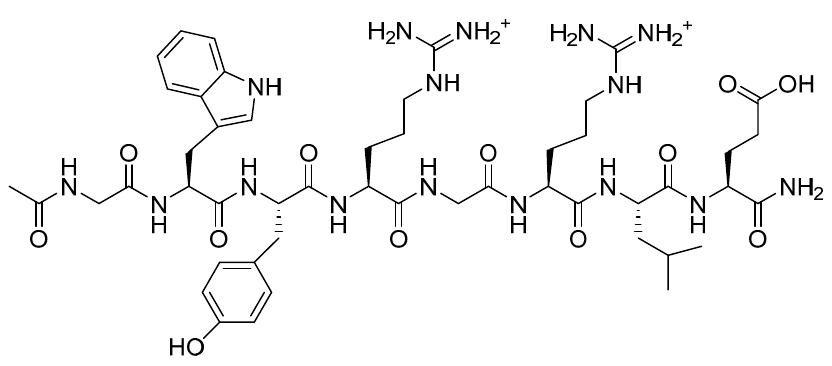
Figure 4. Ac-GWYRGRLE-NH 2